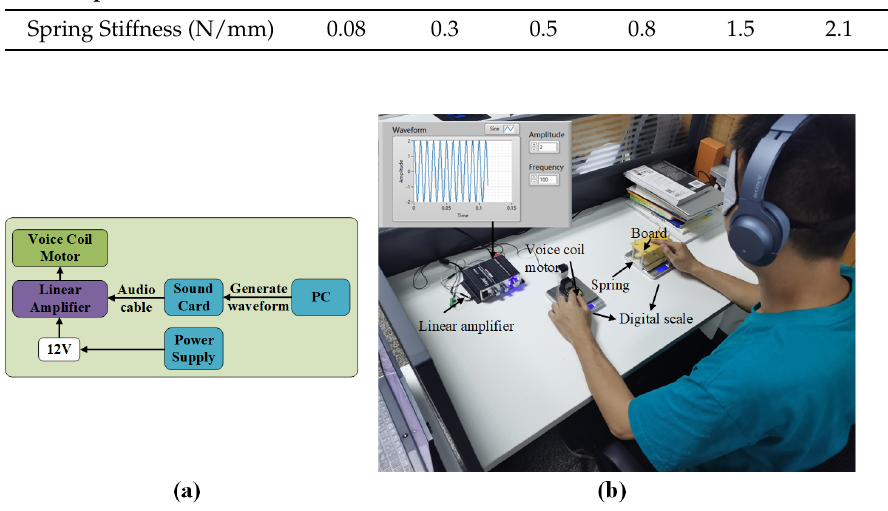
Figure 9. ( a ) The block diagram of the voice coil motor control module. ( b ) Hardness discrimination